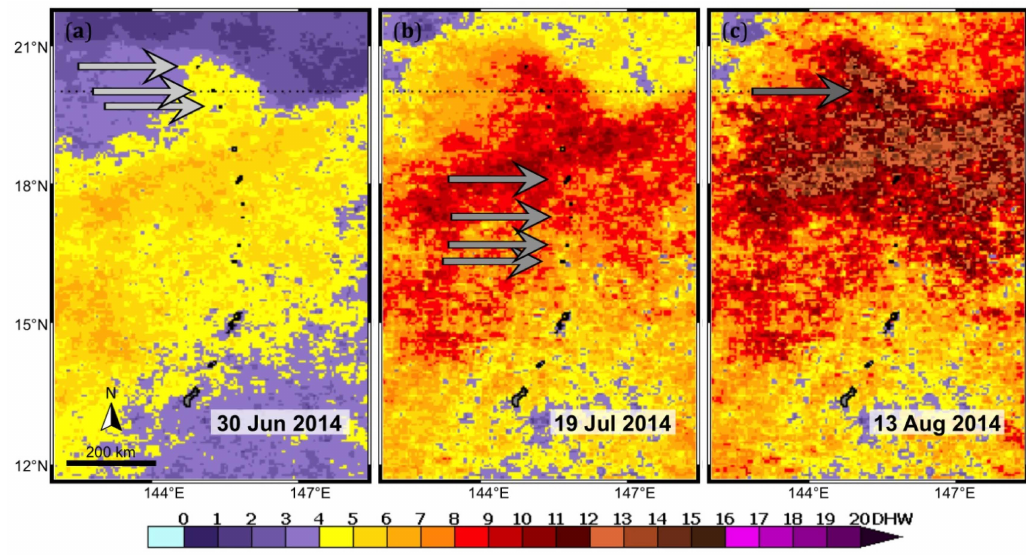
Figure 6. Maps of 5 km Degree Heating Week (DHW) for the Mariana Archipelago when bleaching observation surveys were conducted. ( a ) 30 June 2014; ( b ) 19 July 2014; ( c ) 13 August 2014. Arrows indicate locations of surveys taken within 1–11 days prior to the date shown. Shade of arrows corresponds to the different survey months (also in Figures 3 and